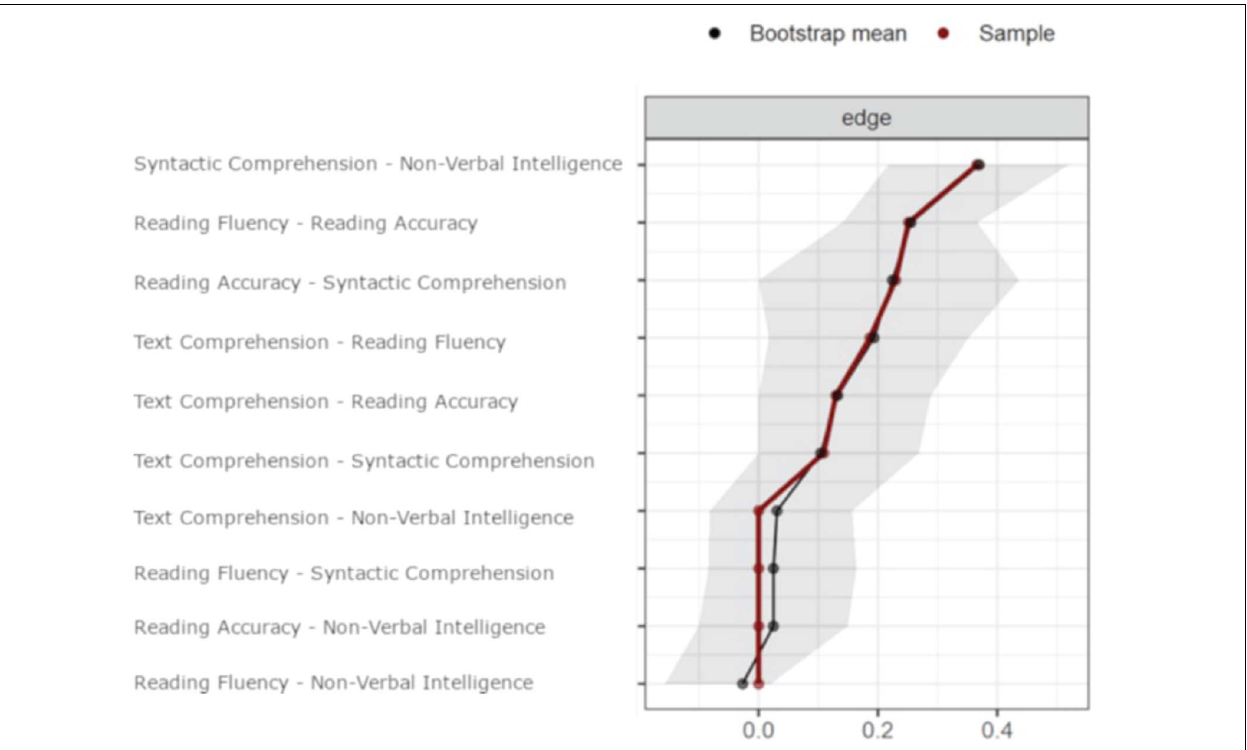
FIGURE 2 | Red dots indicate the edge value of the estimated network. Black dots indicate the average edge value over 1,000 bootstrap resampling. The gray shadow represents the 95% confidence intervals estimated with the bootstrap resampling. Edges are ordered by the estimated